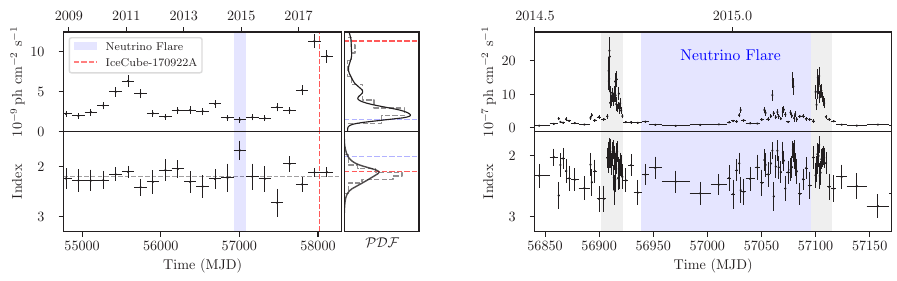
Figure 3. Left : The 158 days, (fixed-binning) γ -ray light curve of TXS 0506 + 056 above 2 GeV. The kernel density estimate of the flux and spectral index distribution are shown as black lines on the plots on the top- and bottom-right, respectively. Right : An adaptive bin light curve for PKS 0502 + 049 above Emin = 214 MeV (see [11] for technical explanation). Note that we go down to lower energies since the PKS 0502 + 049 strongly dominates in this energy regime. Going to higher energies it quickly softens above 934 MeV [10]. The grey shaded area shows the time windows of an increased photon flux. In both plots the blue band indicates the time window of the neutrino